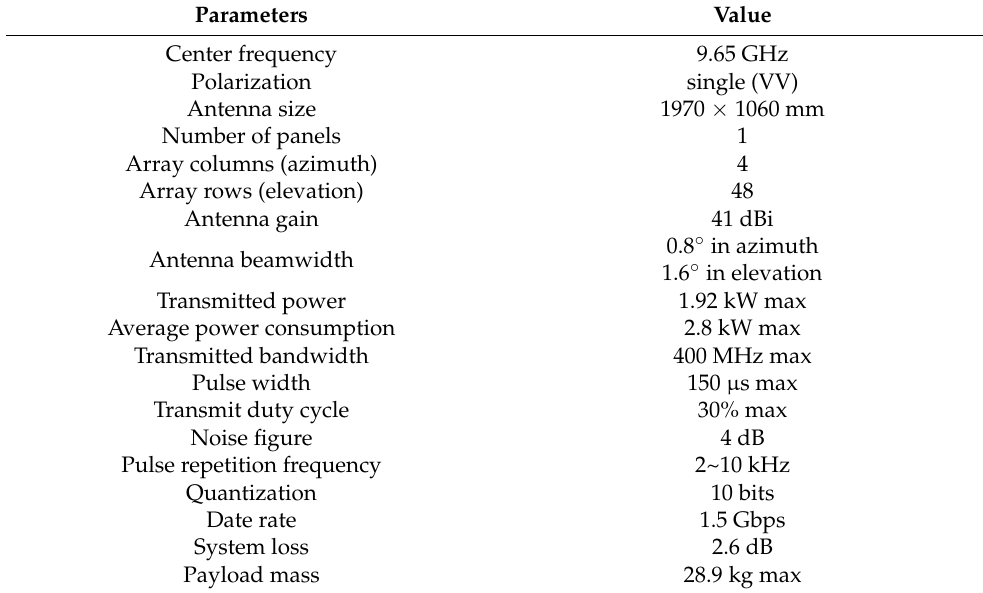
Table 3. Key system parameters of the S-STEP SAR